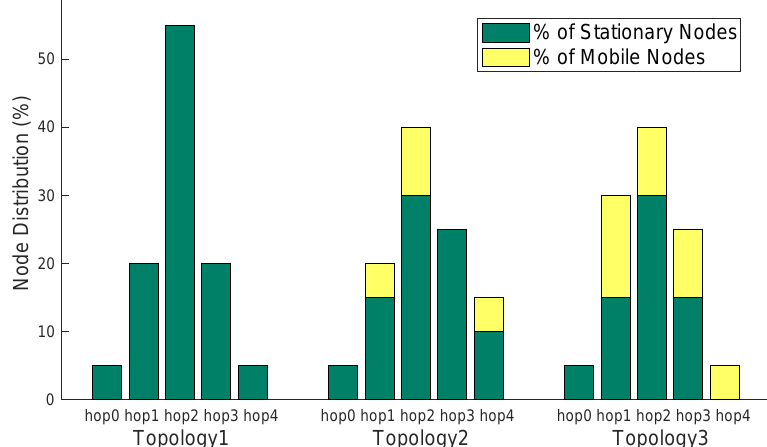
Figure 10. Three node topologies with different portions of mobile nodes with respect to hop distance to a host